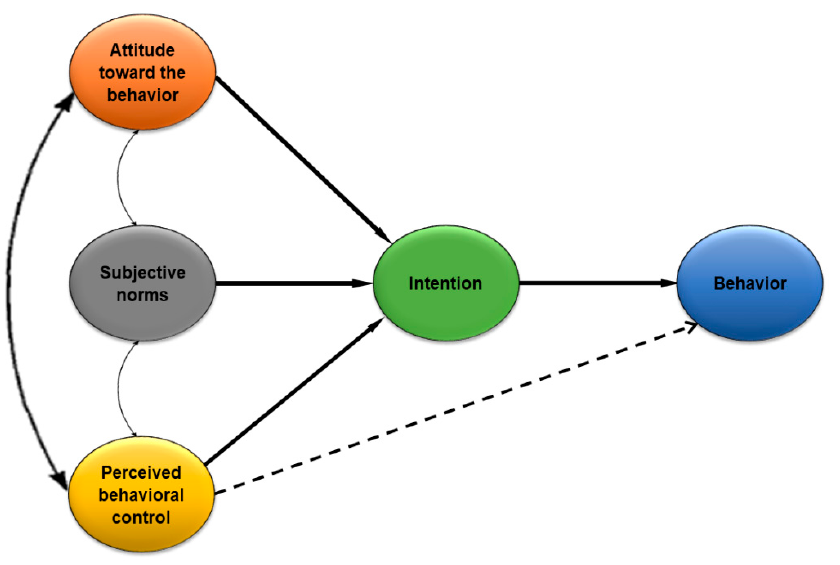
Figure 1. Description of the original TPB model [30].